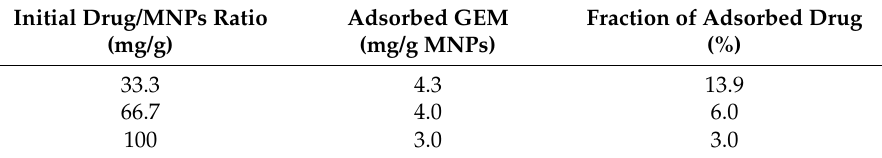
Table 1. GEM adsorbed on MagP–COOH NPs for different initial drug/MNPs ratios.